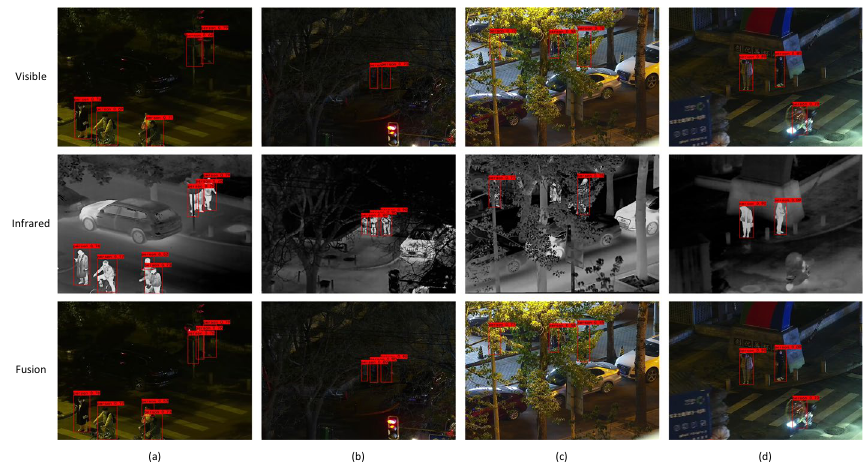
Fig. 6 Comparison of detection results. a , b , c and d are four scenarios under low light confitions respectively